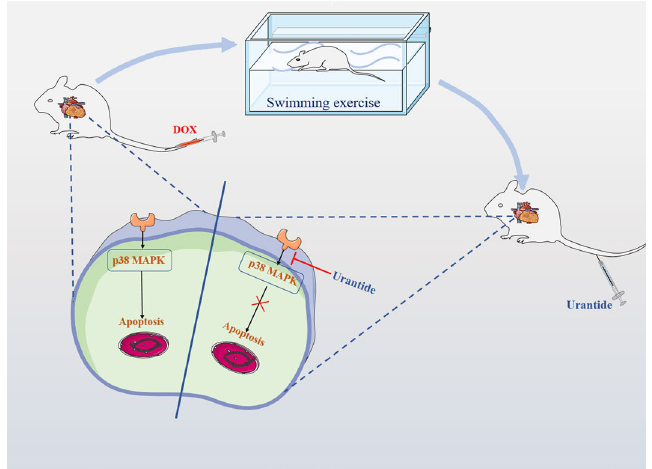
Figure 10. The expression level of the p38 MAPK pathway was upregulated in rats exposed to DOX, while Urantide and exercise were downregulated p38 MAPK and attenuated cardiac